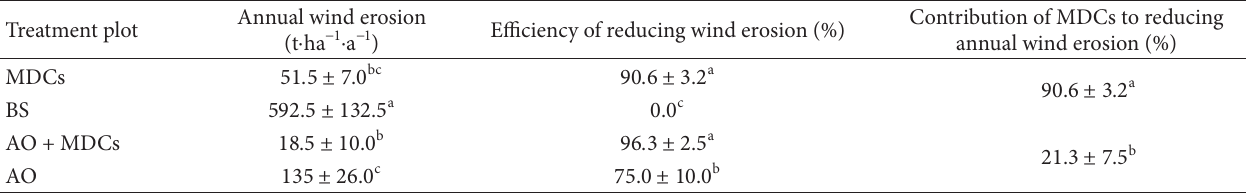
Table 4: Annual wind erosion of moss-dominated crusts alone plots (MDCs), bare sand plots (BS), Artemisia ordosica alone plots (AO), and Artemisia ordosica combined with moss-dominated crusts plots (AO + MDCs) in 2011. Annual wind erosion Efficiency of reducing wind erosion (%) Treatment plot (t ⋅ ha − 1 ⋅ a − 1 )